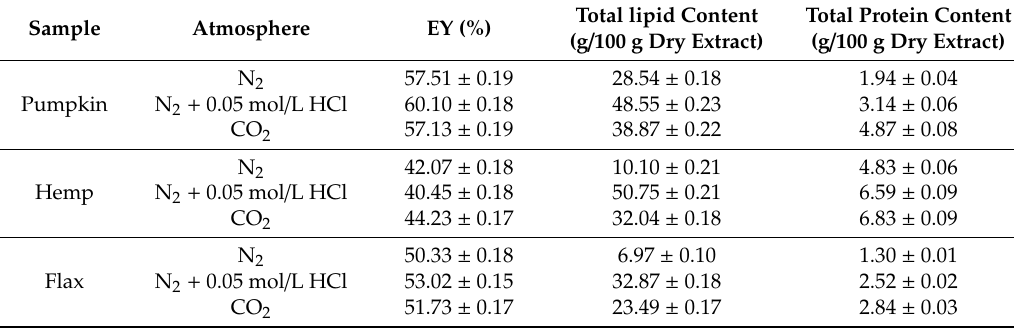
Table 1. Extraction yields (EY, g dry extract / 100 g seed cake) and extract composition (lipid and protein content, g / 100 dry extract) of pumpkin, hemp and linseed cakes obtained with subcritical water extraction at 160 ◦ C, 20 bar for 1 h under di ff erent